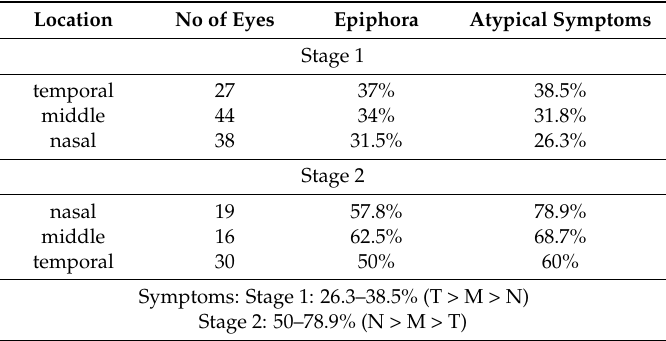
Table 3. Symptoms according to stage per location.